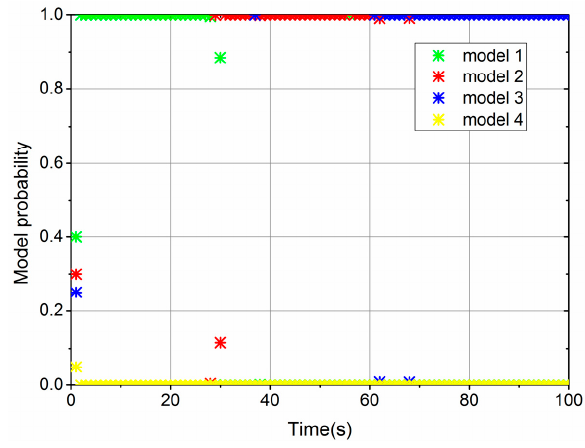
Figure 6. The model probabilities by using UIMM in simulation 1.